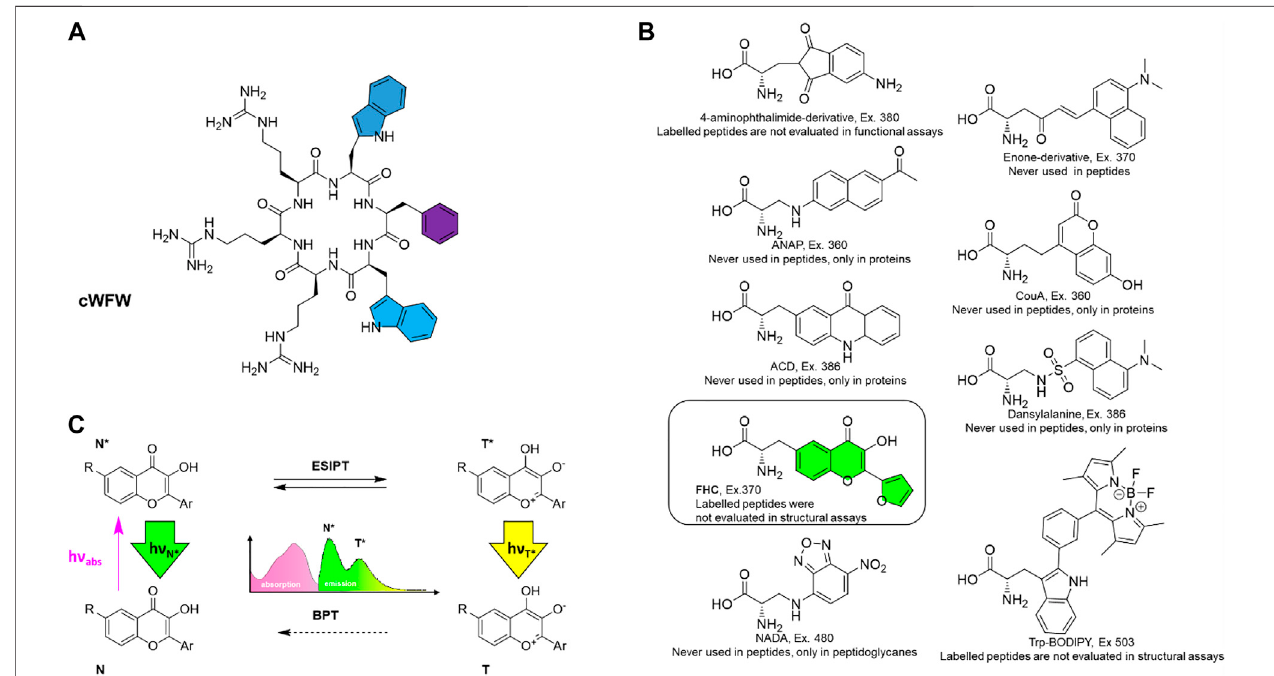
FIGURE 1 | (A) Structure of the antimicrobial peptide cWFW with colour-highlighted aromatic residues that were individually substituted by the fl uorescent label in this study; (B) the fl uorescent amino acid FHC used as the label (framed and colored) along with potential alternatives, i.e., reported fl uorescent amino acids with the excitation wavelengths higher than 360 nm. Compounds are designated according to original reports, excitation wavelengths ( “ Ex. ” ) are stated; (C) excited-state intramolecular proton transfer (ESIPT)-mediated fl uorescence, causing dual emission and environmental sensitivity of the chromophore in 3-hydroxychromone- containing labels. N (N*) and T (T*) represent normal and tautomeric forms, respectively, in the ground (excited) state; BPT denotes back proton transfer in the ground state.